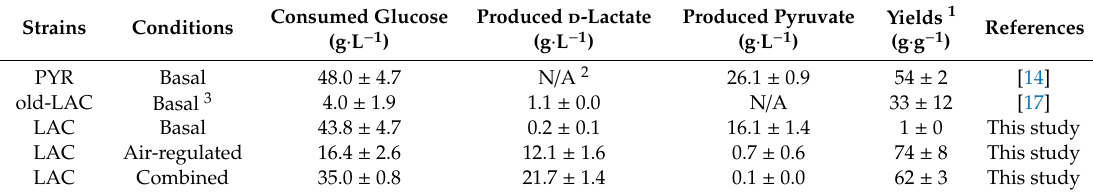
Table 2. Summary of culture profiles at 72 h.